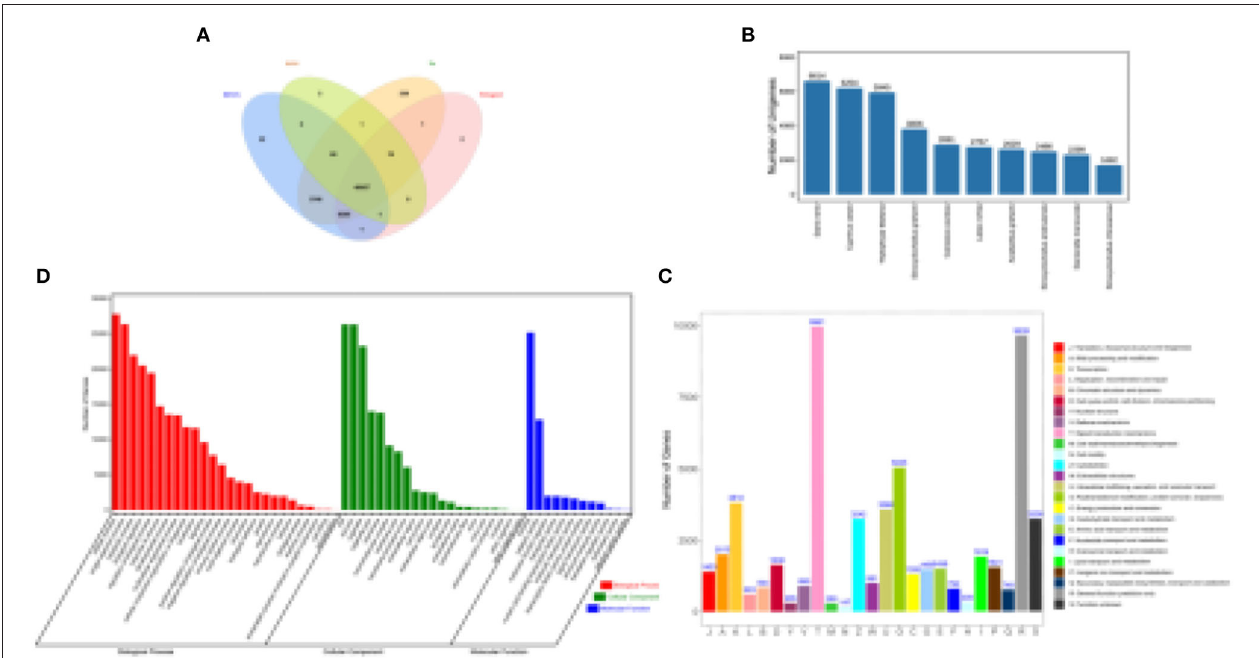
FIGURE 1 | Characterization of functional annotation. (A) Overlapping of the different results annotated by four databases. (B) Protein taxonomic distribution annotated by non-redundant protein database. (C) Two levels of GO functional annotations of full-length transcripts. (D) Functional classification annotated in the EuKaryotic Orthologous Groups (KOG)